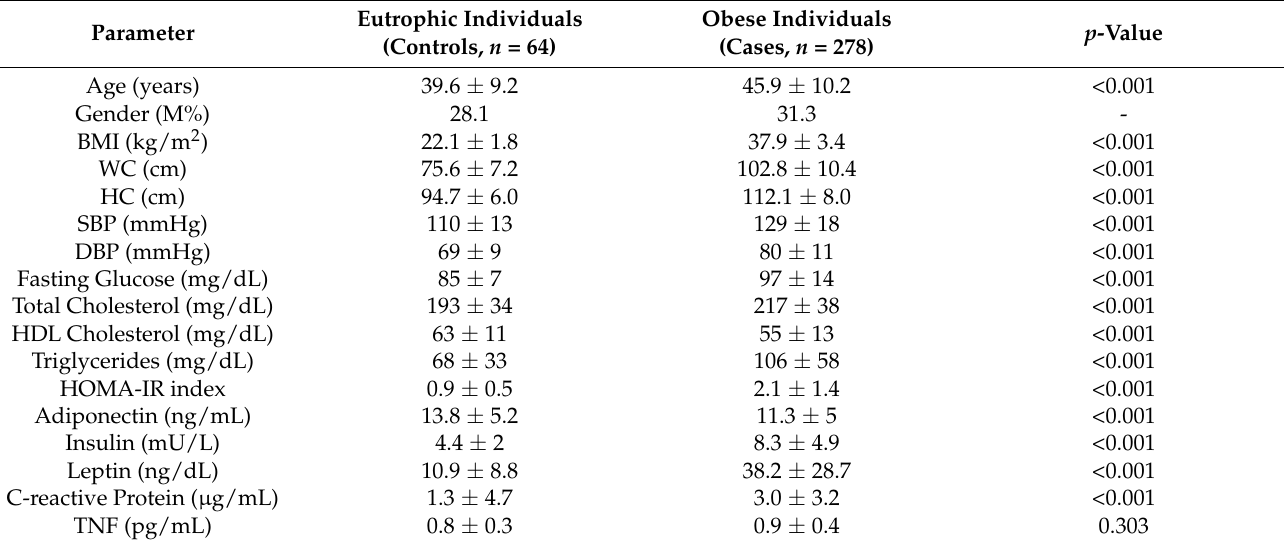
Table 1. Anthropometric and clinical data of the study